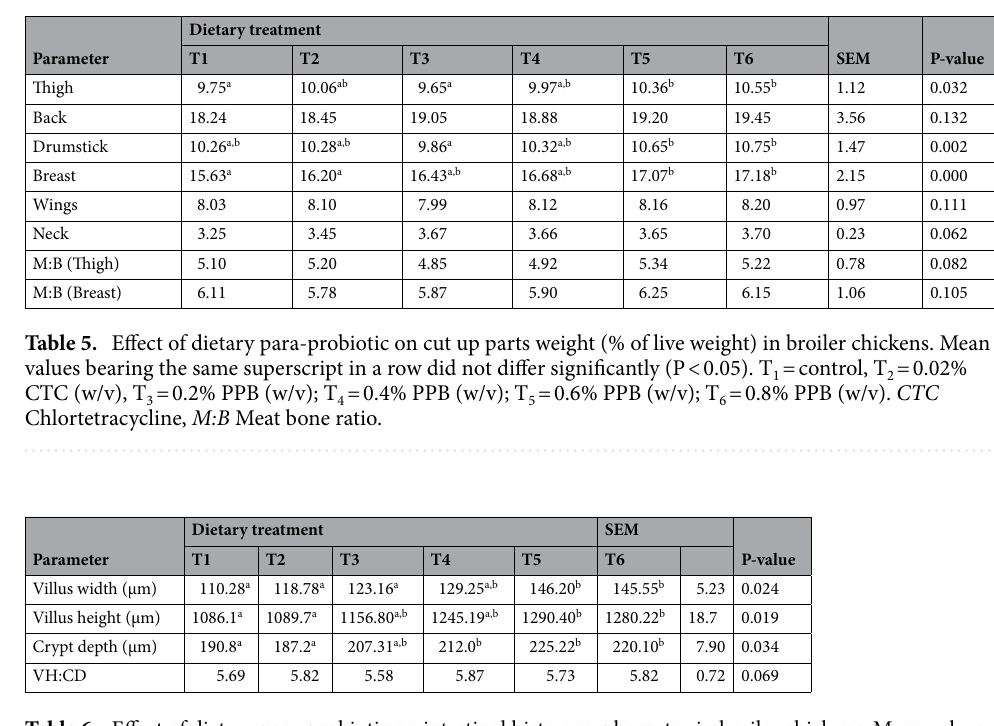
Table 6. Effect of dietary para-probiotic on intestinal histo-morphometry in broiler chickens. Mean values bearing the same superscript in a row did not differ significantly (P < 0.05). T 1 = control, T 2 = 0.02% CTC